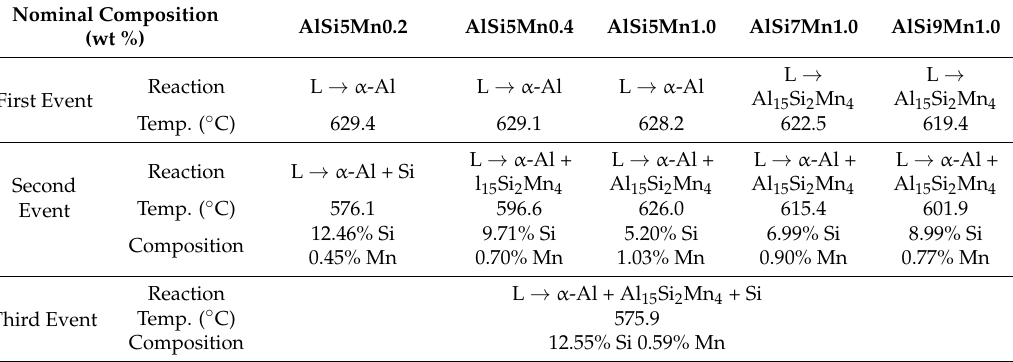
Table 1. Calculated solidification paths for investigated alloys. All compositions given in weight